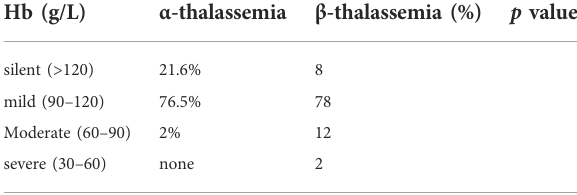
TABLE 3 The degrees of anemia between α -thalassemia and β -